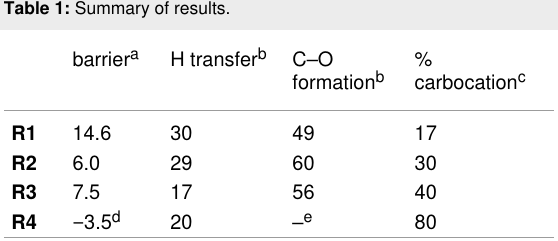
Table 1: Summary of